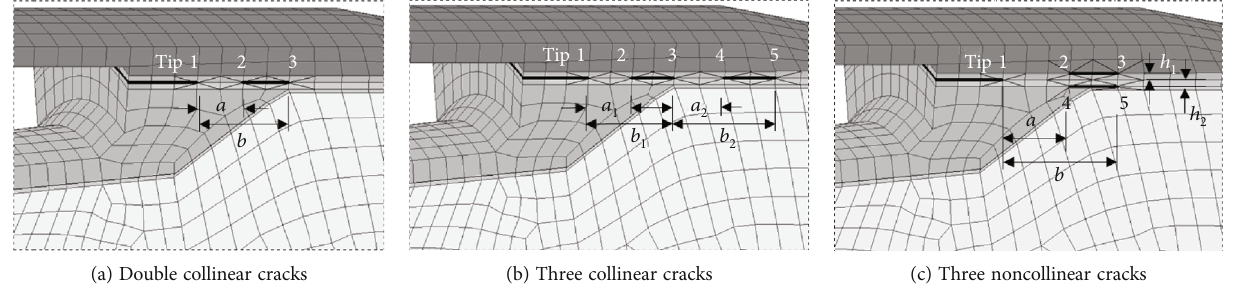
Figure 8: The insulation crack group in the fore area of stress-release boot of SRM